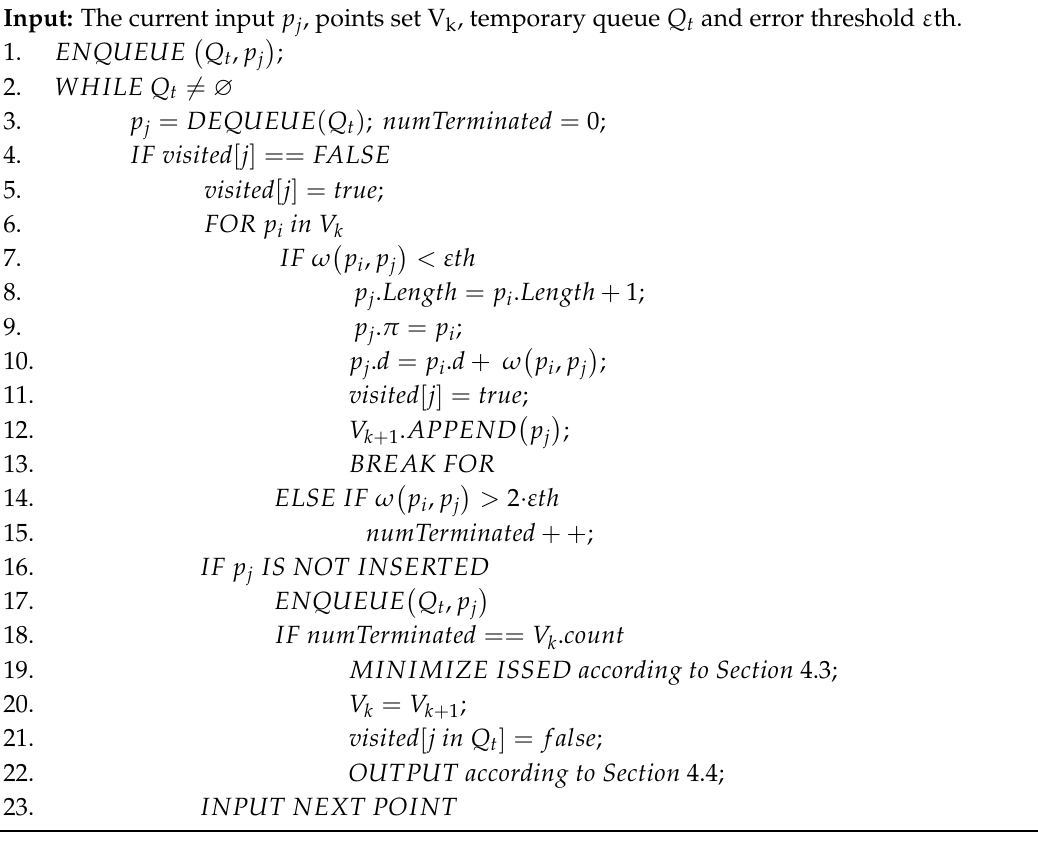
Algorithm 1. Dynamic Breadth-First Spanning Tree Construction (Iteration k )